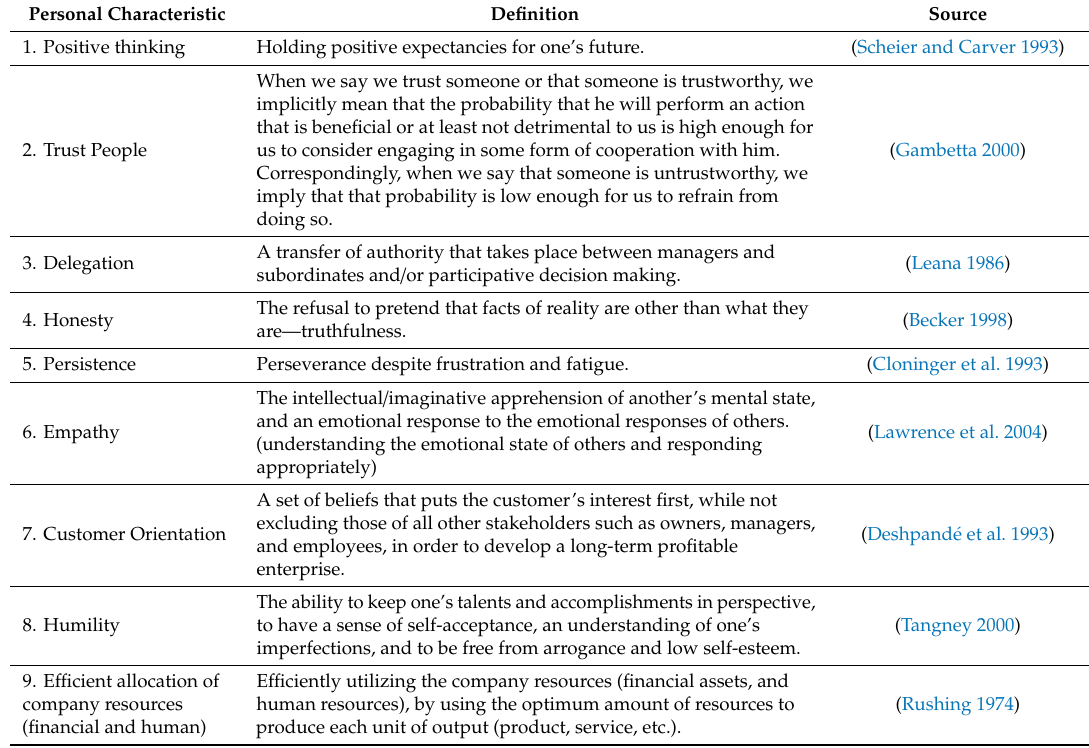
Table 4. Definitions of personal characteristics that the entrepreneurial team (founders) of an innovative technology enterprise may